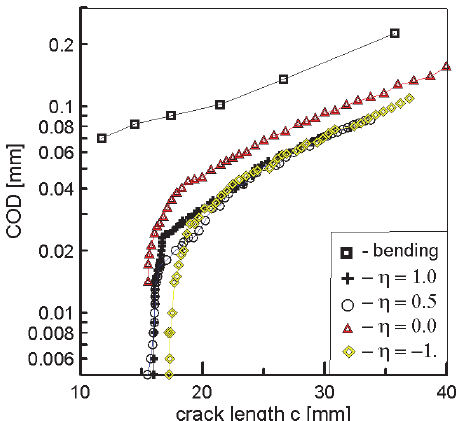
Figure 10: Relationship between COD and crack length on free surface of cruciform specimens and bending plate. Fig. 11a represents the superficial crack growth rate dc/dN versus COD on the cruciform specimens undergoing